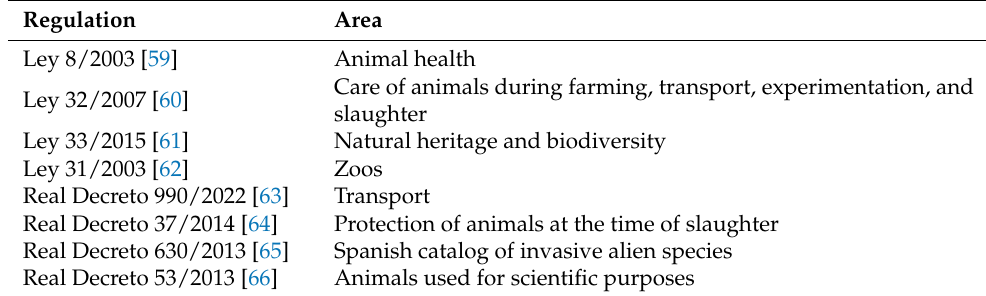
Table 3. Spanish regulations on animal protection and